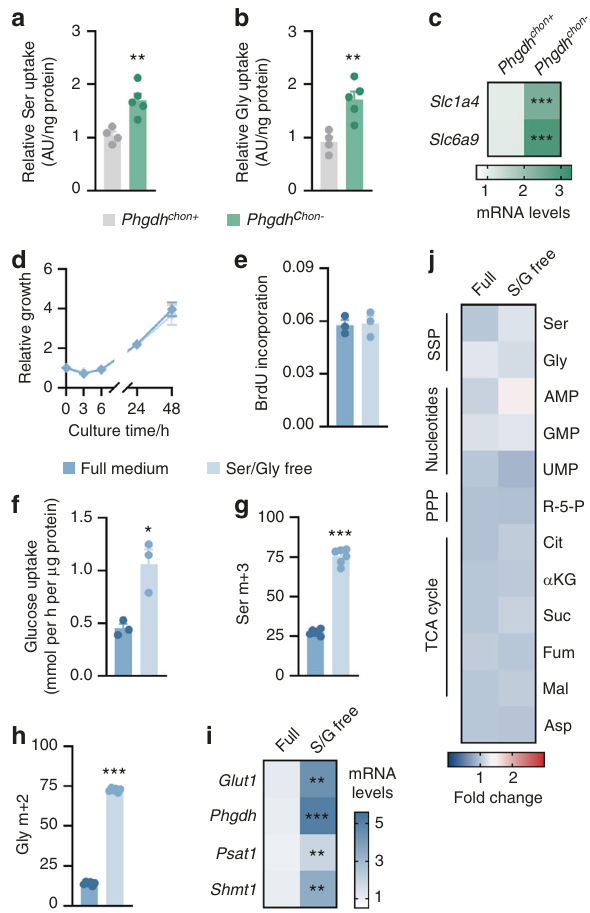
Fig. 4 Complementary action of serine uptake and synthesis in challenged chondrocytes. Relative serine (Ser; a ) and glycine (Gly; b ) uptake in cultured chondrocytes derived from wild-type ( Phgdh chon + ) and curve of chondrocytes cultured in complete growth medium or serine/glycine-free medium ( n = 3), based on their DNA content. e Proliferation of chondrocytes cultured in complete growth medium or serine/glycine-free medium ( n = 3), as evidenced by BrdU incorporation. f Glucose uptake in chondrocytes cultured in complete growth medium or serine/glycine-free medium ( n = 4 – 5). Serine ( g ) and glycine ( h ) labeling from 13 C 6 -glucose in chondrocytes cultured in complete growth medium or serine/glycine-free medium ( n = 6). Speci fi c mass distribution vectors for each metabolite are shown. i Glut1 , Phgdh , Psat1 , and Shmt1 mRNA levels in chondrocytes cultured in complete growth medium or serine/glycine-free medium ( n = 3). j Intracellular levels of the indicated metabolites in Cit represents citrate, α KG represents α -ketoglutarate, Suc represents succinate, Fum represents fumarate, Mal represents malate and Asp Phgdh chon + (Student ’ s t